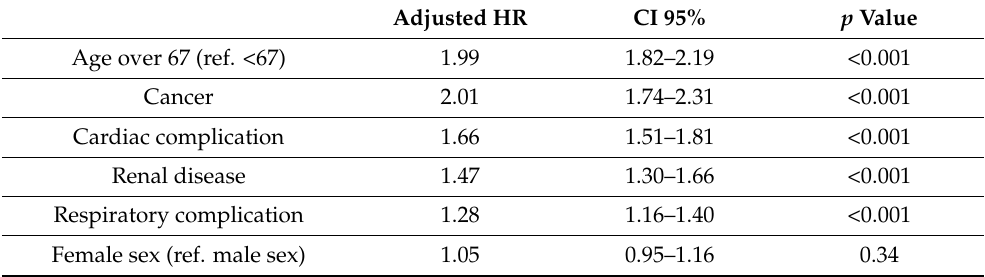
Table 4. Factors associated with overall